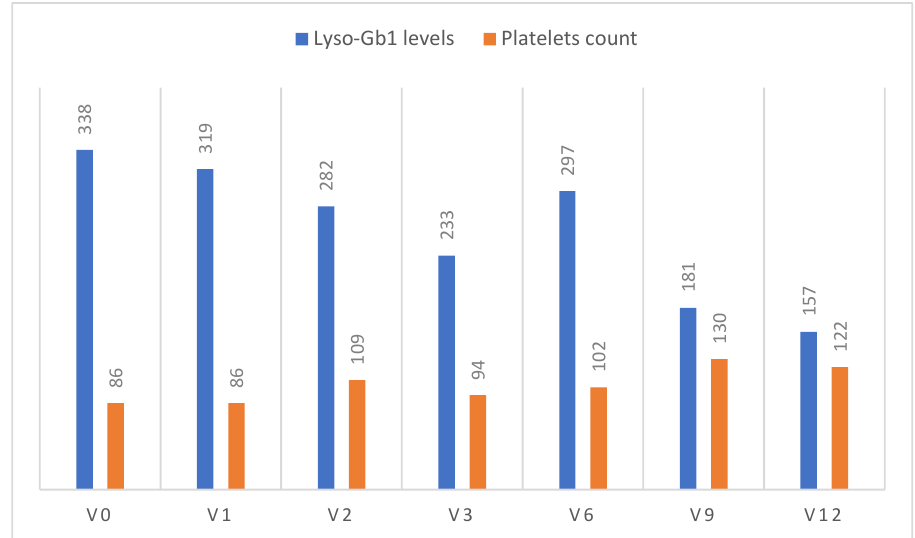
Figure 2. Changes in platelet counts and Lyso-Gb1 levels from visit (V) 0 (enrollment) to the end of the study (V12) for Case 1.